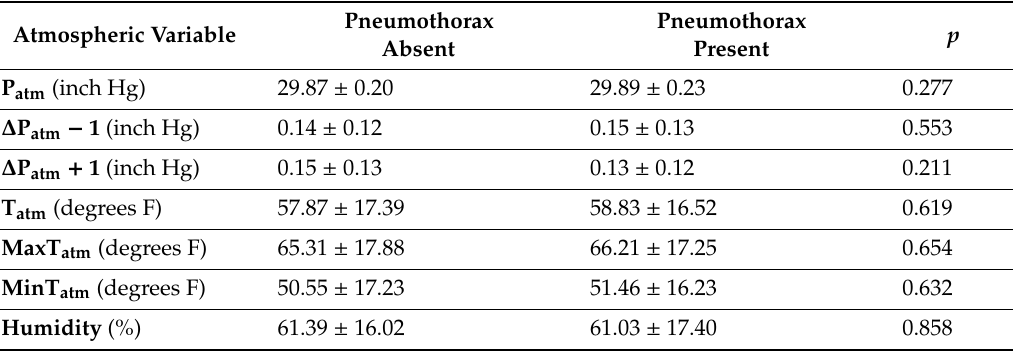
Table 4. E ff ect of the atmospheric variables on the rate of pneumothorax after CT-guided lung biopsy. Pneumothorax Atmospheric Variable